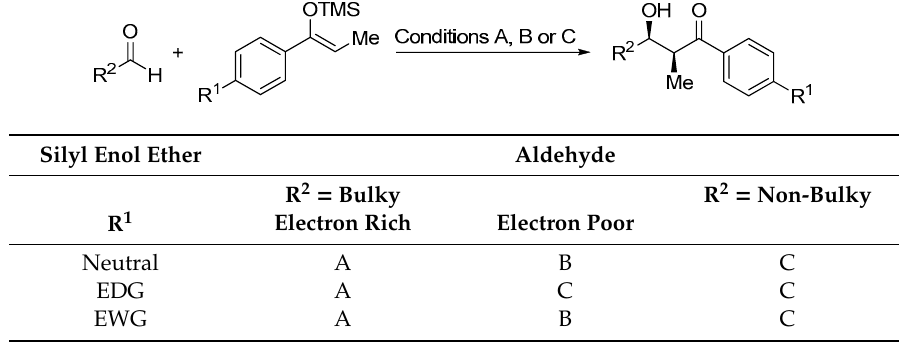
Table 9. Optimized reaction conditions in Mukaiyama aldol reaction of silyl enol ether with aldehydes.